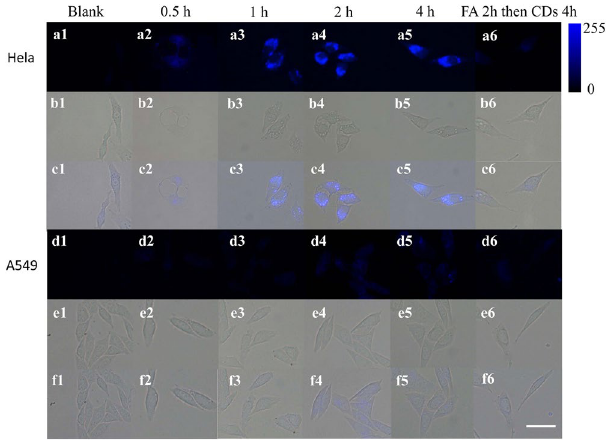
Figure 4. Fluorescence images of Hela and A549 incubated with the FA derived CDs (100 μ g/mL) at 37 °C for different incubated time, 0 h ( a1,d1 ), 0.5 h ( a2,d2 ), 1 h ( a3 , d3 ), 2 h ( a4,d4 ), and 4 h ( a5,d5 ). As another control, Hela and A549 pre-treated at 37 °C for 2 h with excess FA for FR saturation, and then incubated with CDs (100 μ g/mL) at 37 °C for 4 h ( a6,d6 ). Bright field images are shown in b and e. The overlay images are shown in c and f. Scale bar: 10 μ